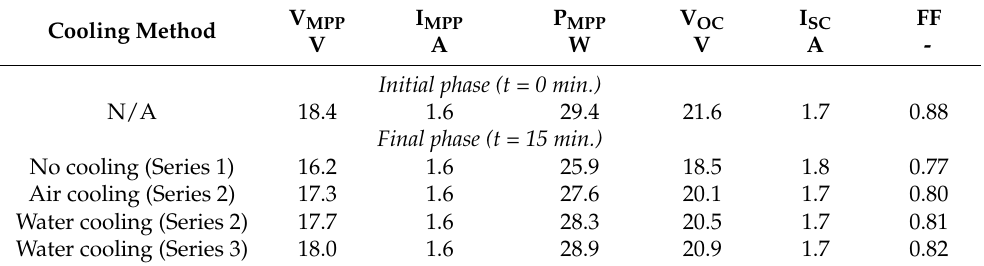
Table 1. Variations in the operating parameters of the tested 50 Wp PV panel depending on the cooling method.